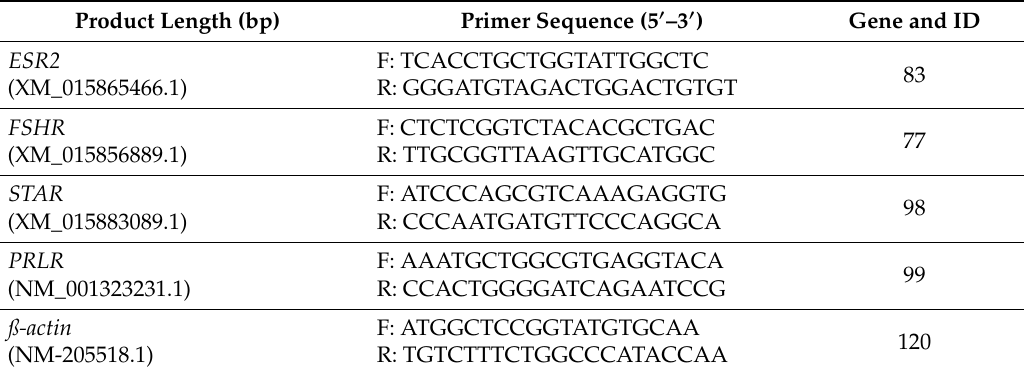
Table 3. Used primers for the quantitative real-time